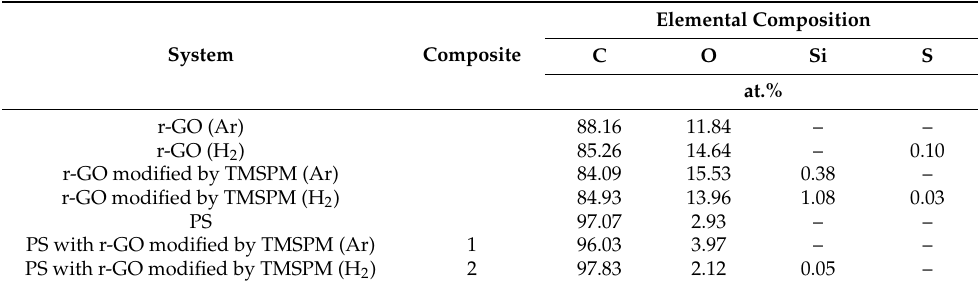
Table 1. EDX analysis data of polystyrene (PS)/laser-reduced graphene oxide (r-GO) composites and their